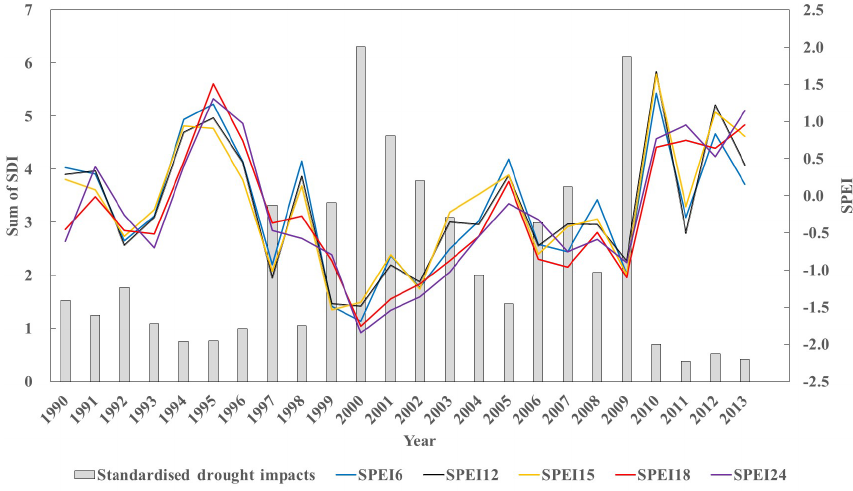
Figure 2. Standardised precipitation evapotranspiration index (SPEI) for 6-, 12-, 15-, 18- and 24-month accumulation periods, and the sum of the standardised drought impacts (SDIs) for each impact type listed in Table 1 for Liaoning province from 1990 to